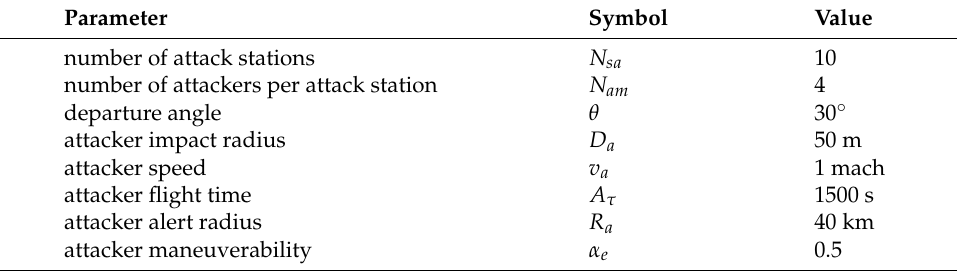
Table 2. Parameters of attack force.